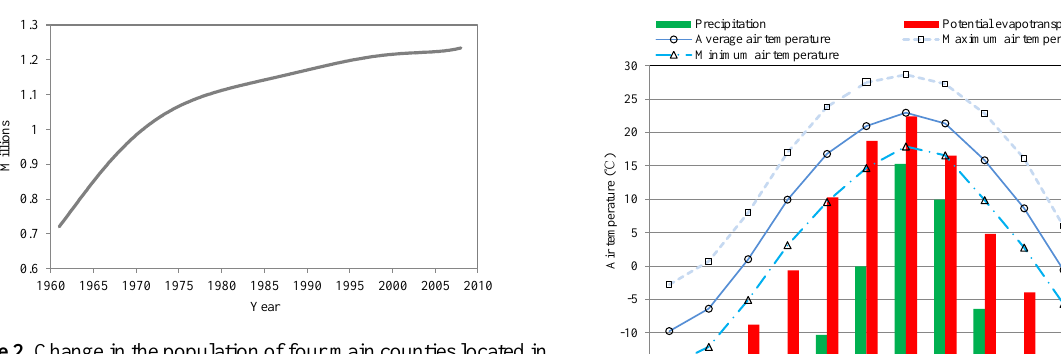
Figure 2. Change in the population of four main counties located in Hebei Province from 1961 to 2007.